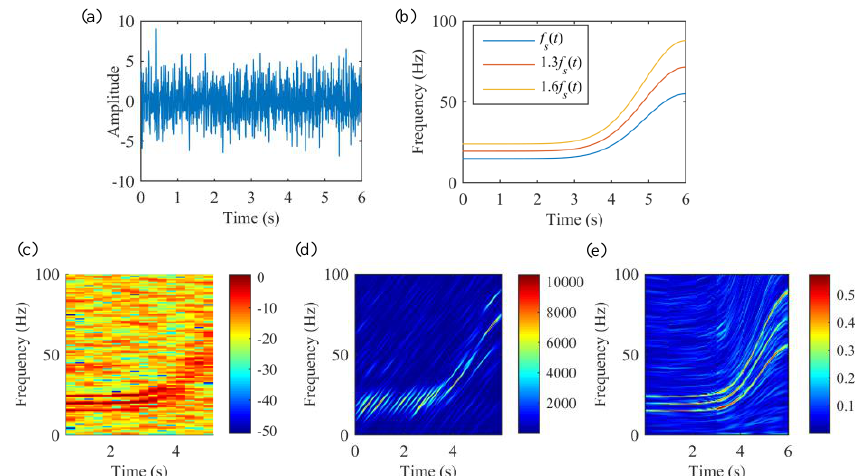
Figure 4. Time frequency analysis (TFA) for noisy multicomponent signal: ( a ) noisy signal, ( b ) real IF ridges of signal components, ( c ) TFR obtained using STFT, ( d ) TFR obtained using CT, and ( e ) TFR obtained using proposed FMLT.